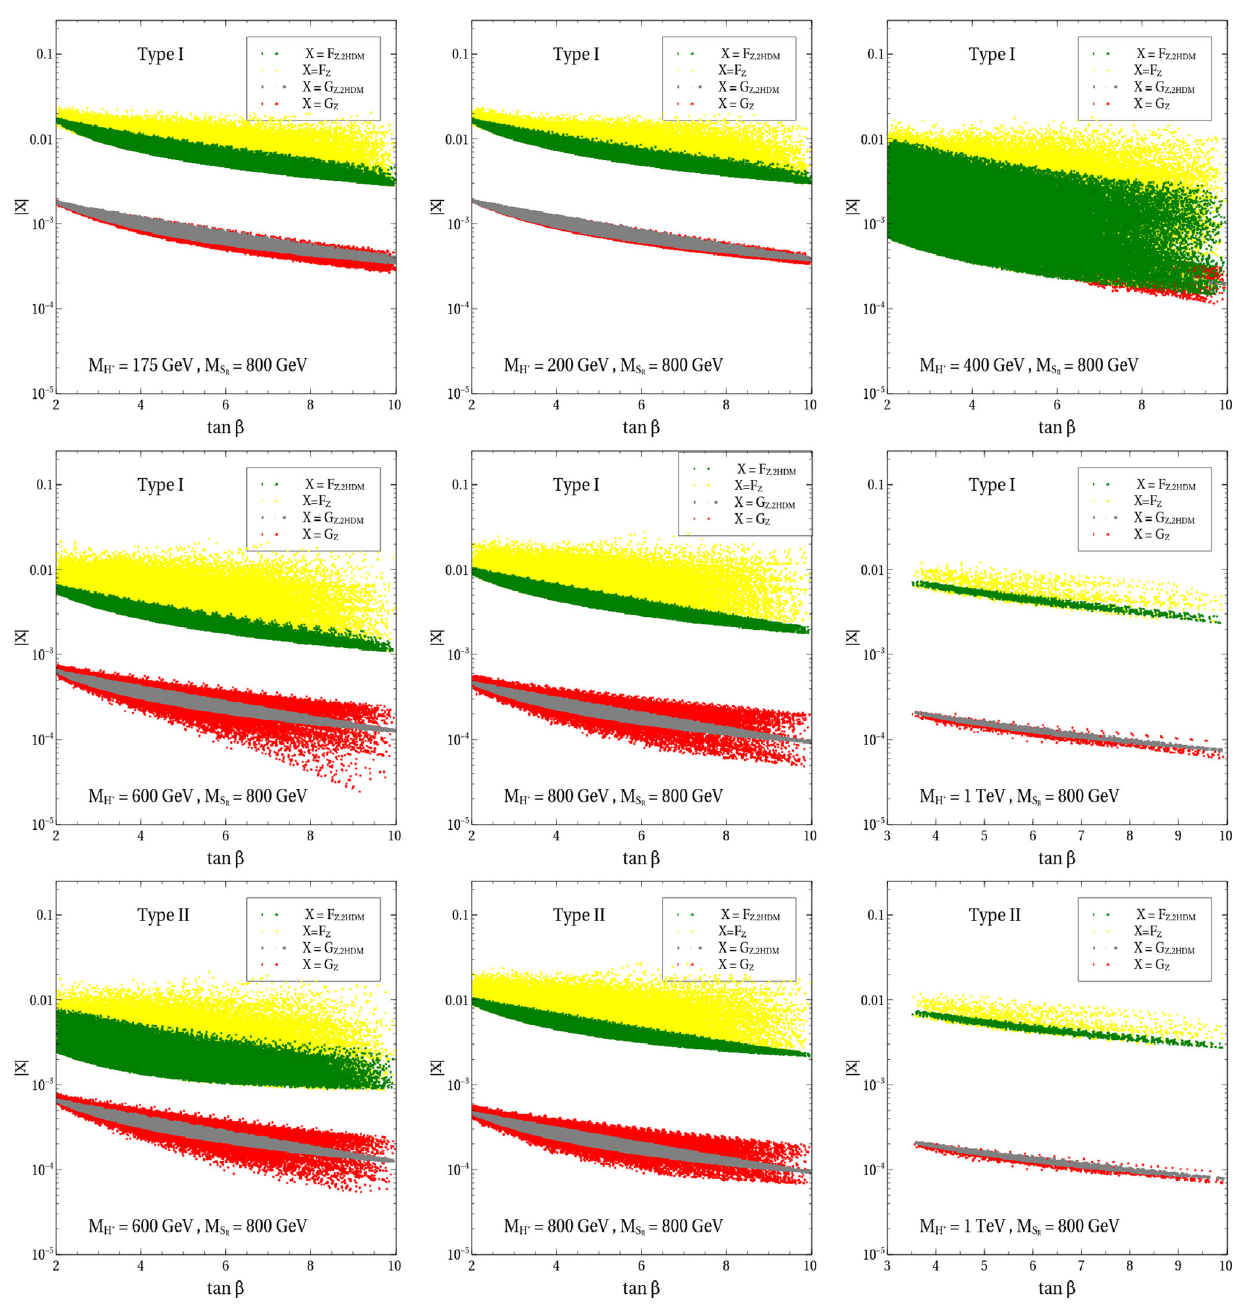
Fig. 10 Variation of absolute value of the form factors X = F Z , G Z , F Z , 2HDM , G Z , 2HDM with tan β for M H + = = 800 GeV for Type-I and Type-II 2HDM. Color coding is expressed in legends 175 , 200 , 400 , 600 , 800 , 1000 GeV and M S R